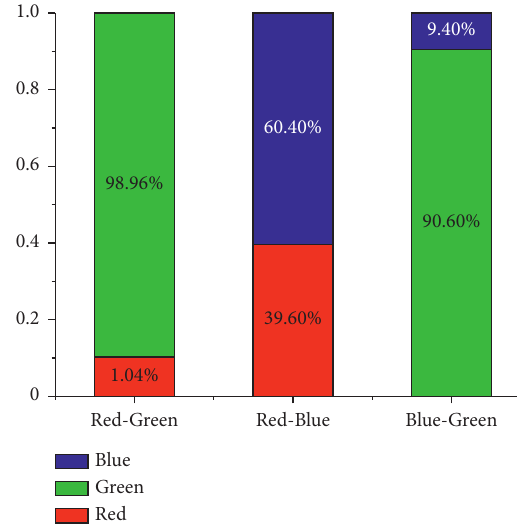
Figure 7: Statistics of experimental